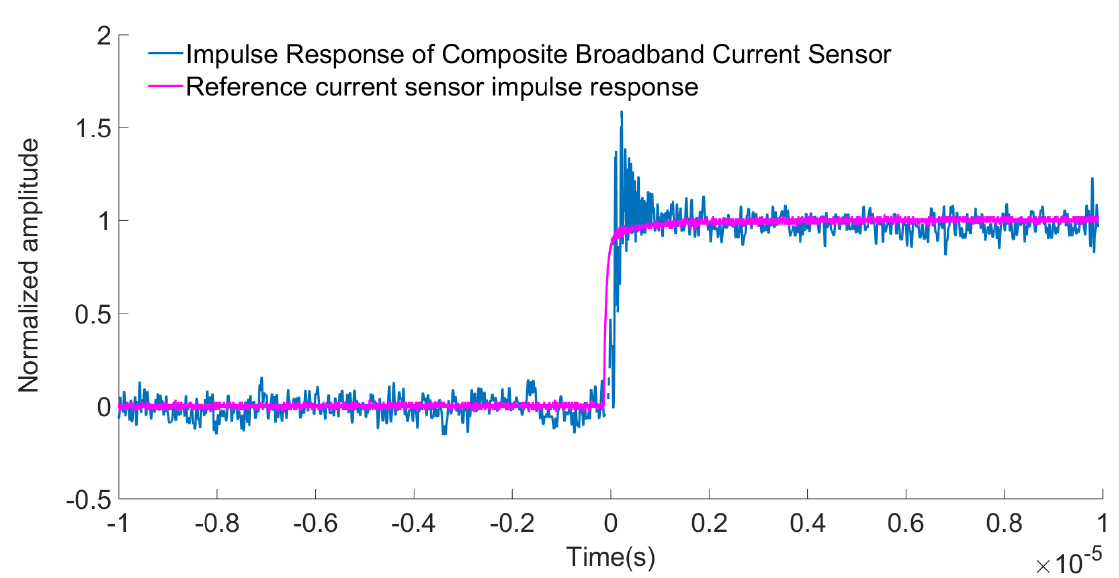
Figure 25. Response diagram of the sensor pulse signal.